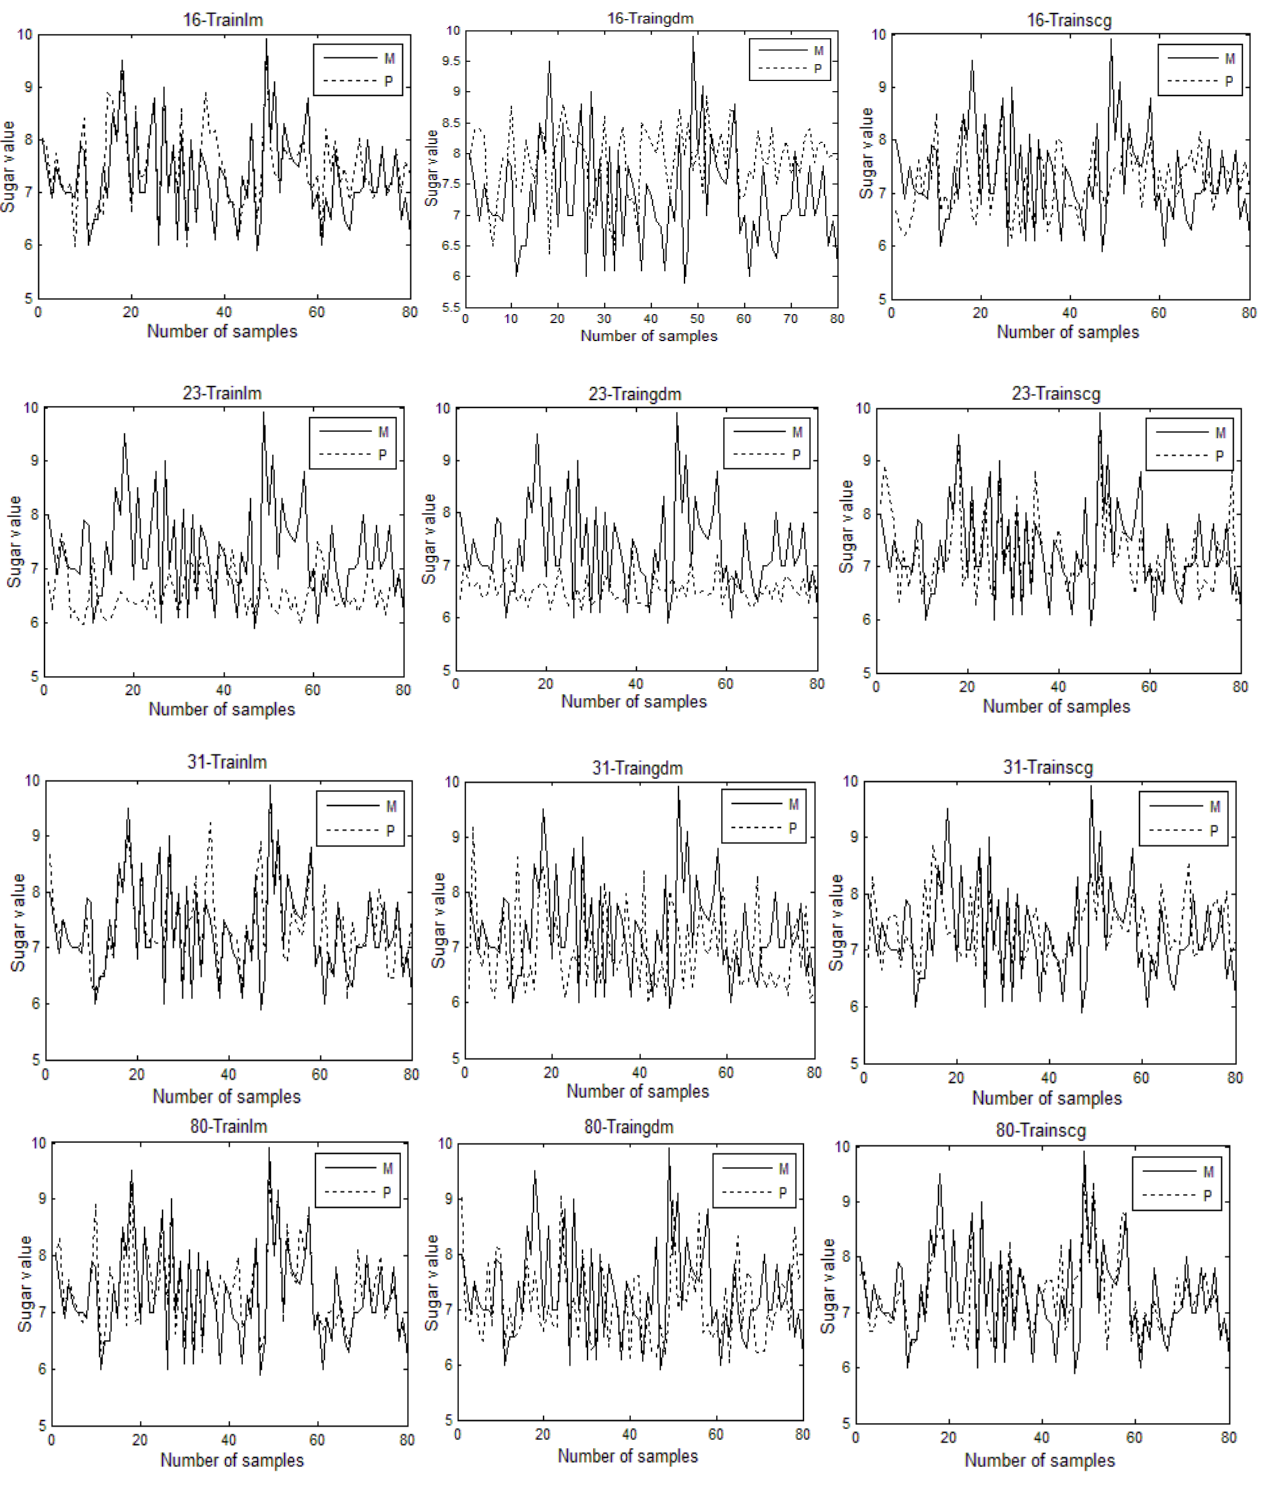
Figure 13. The graph of model prediction results (M — Measured value, P — Predictive value). Table 11. Model prediction results.